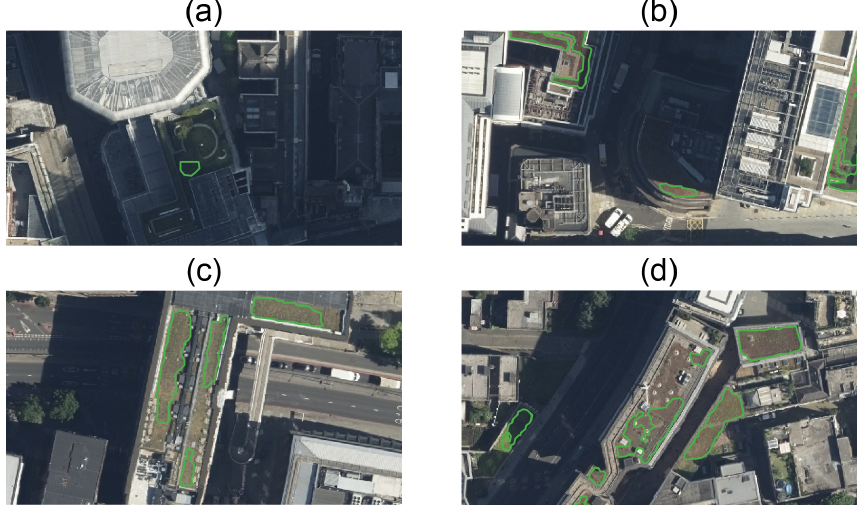
Figure 9. Examples of false negative classification in the 2021 imagery. The green outline shows the area identified as green roof by the model. Imagery © GetMapping Plc. Image location is shown in Fig.